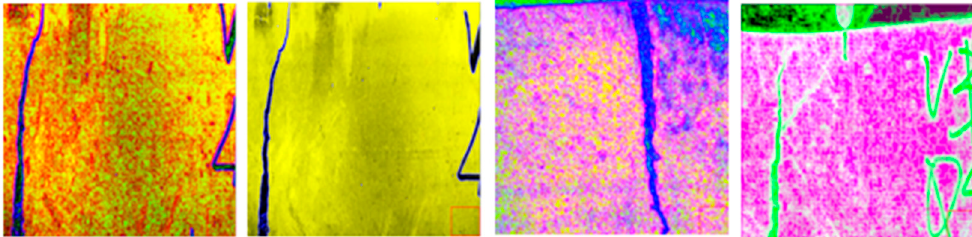
Figure 8. Merge texture feature images.